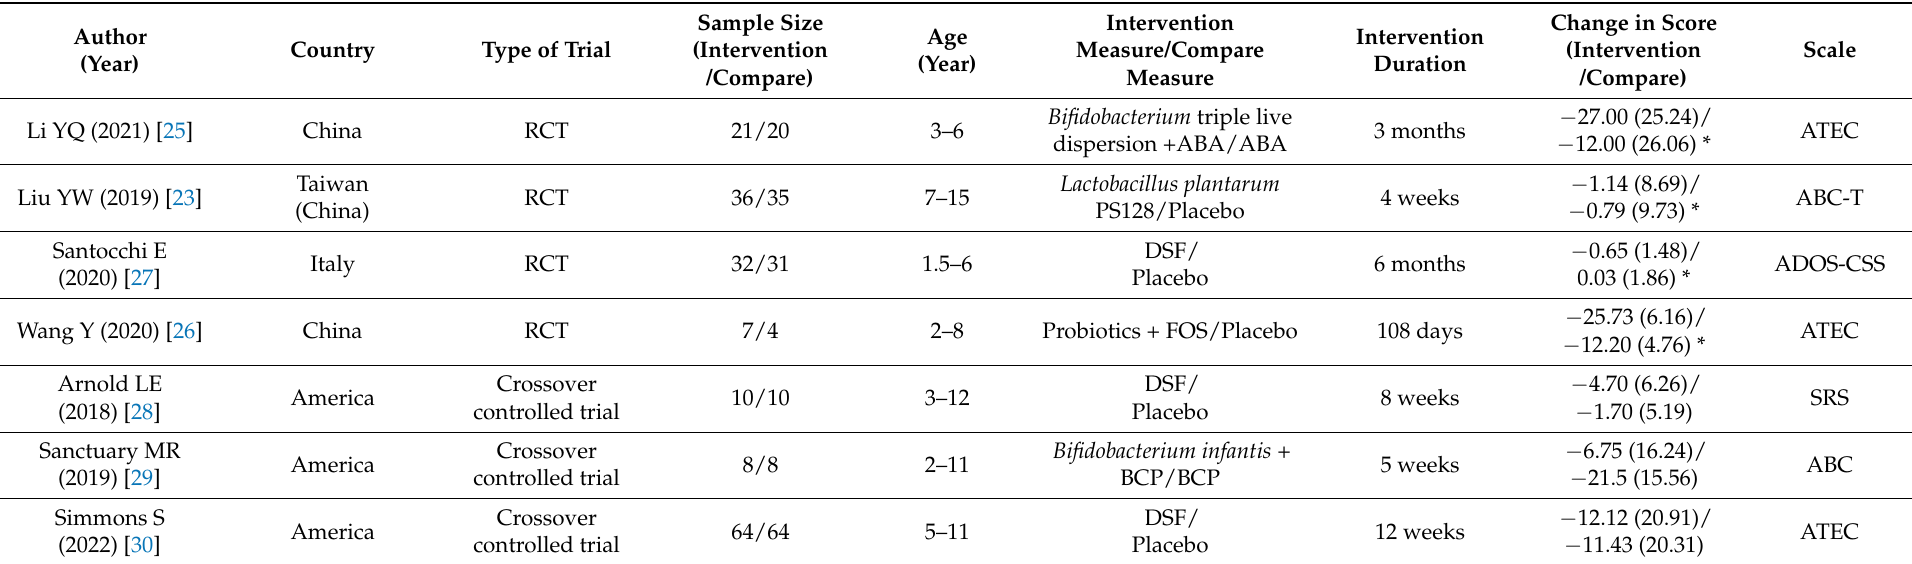
Table 2. The characteristics of studies included in the